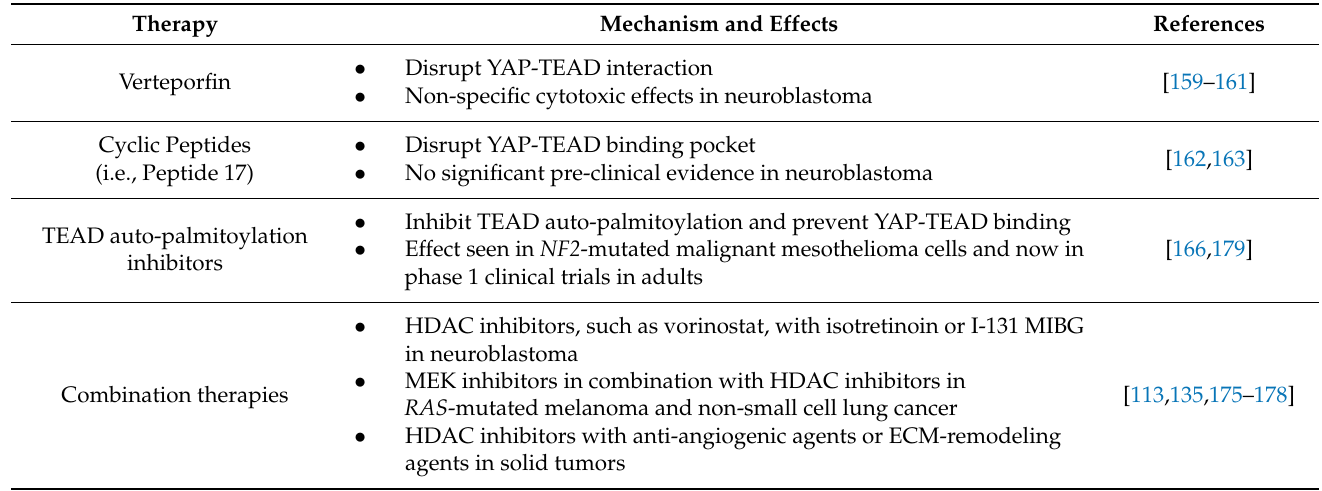
Table 2. Potential therapies to target YAP and related